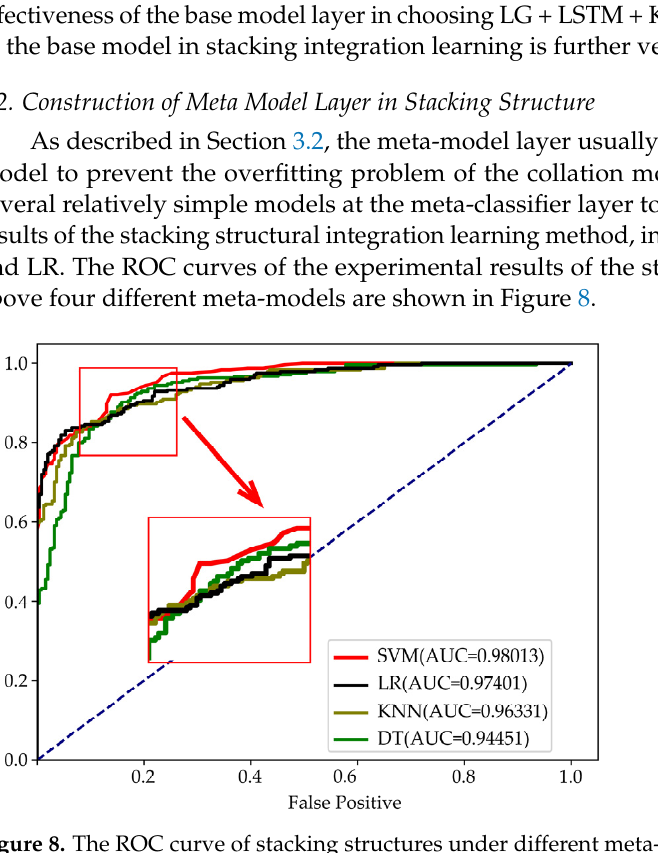
Figure 7. Matrix of correlation coefficients for the value of the classification prediction indicator between classifiers.